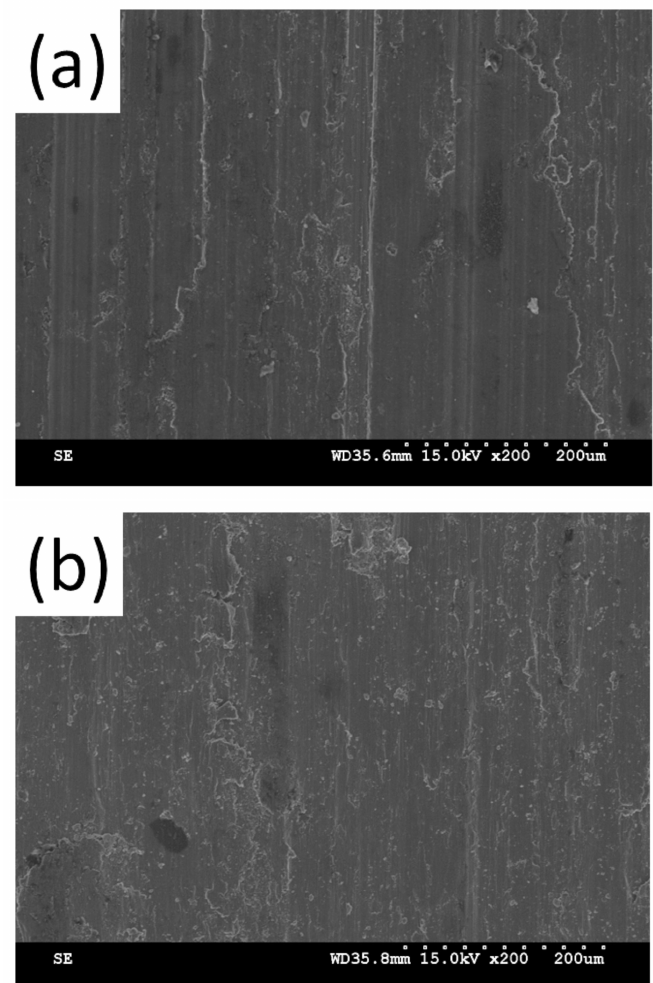
Figure 13. SEM images of wear track for Al ( a ) and Ti ( b )